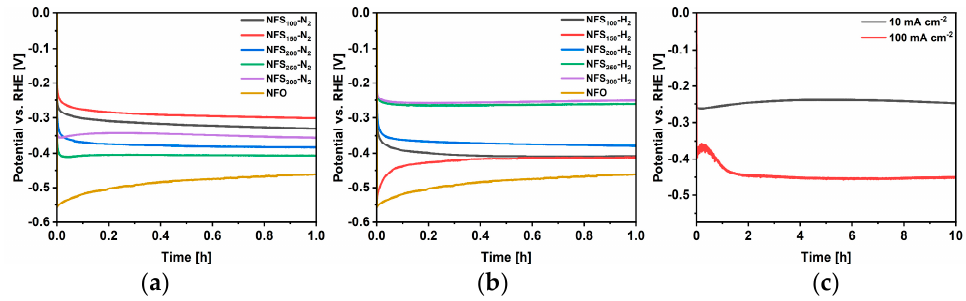
Figure 3. Chronopotentiometry data obtained from the ( a ) NFS − N 2 electrocatalysts at 10 mA cm − 2 , ( b ) NFS − H 2 electrocatalysts at 10 mA cm − 2 and ( c ) NFS 300 − H 2 electrocatalyst at − 10 and 100 mA cm − 2 for 10 h.